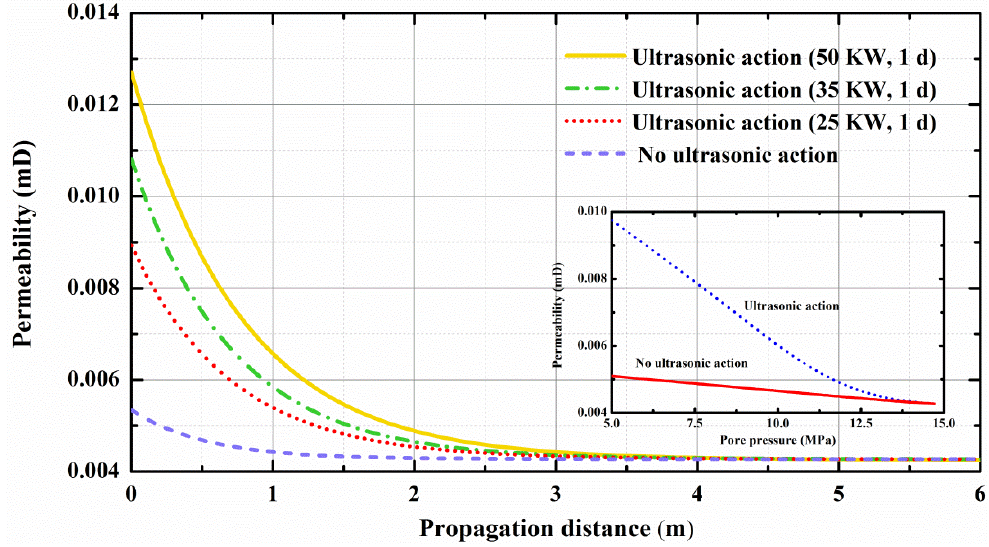
Figure 7. Simulation results of reservoir permeability changes without and with ultrasonic waves.